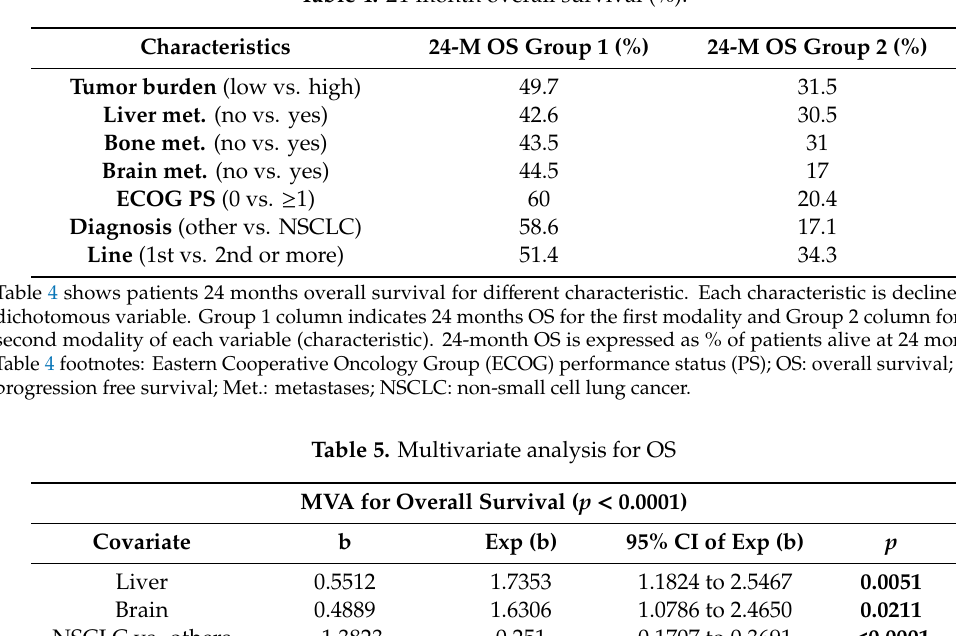
Table 4. 24-month overall survival (%).